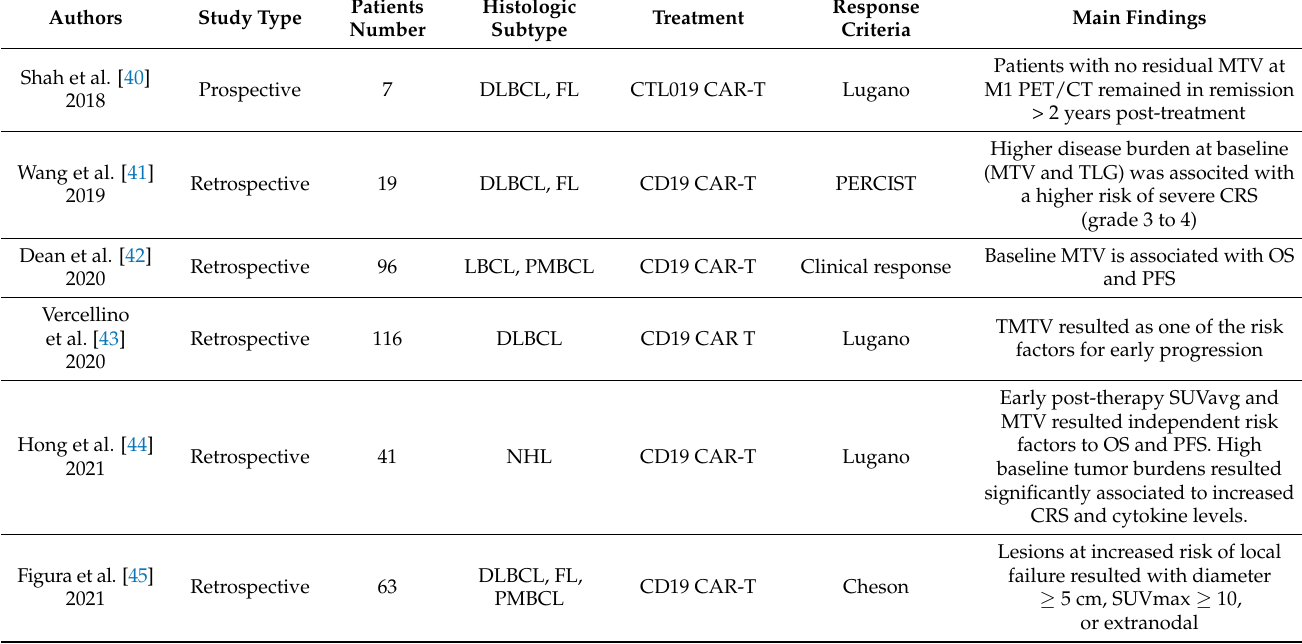
Table 2. Summary of available studies investigating [ 18 F]FDG PET/CT in lymphoma treated with CAR-T.